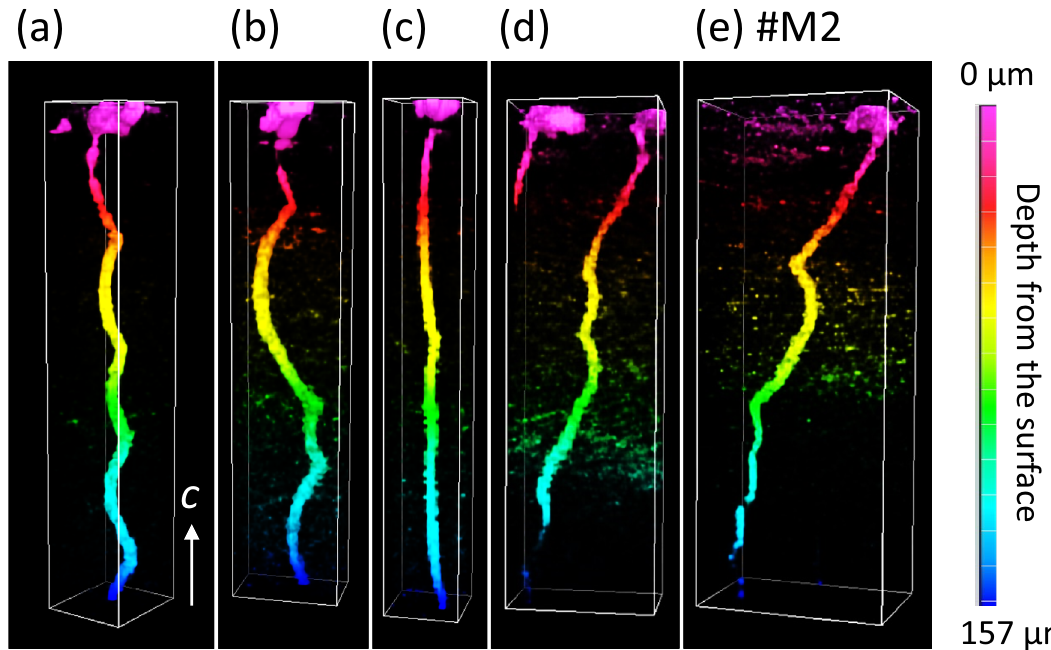
Figure 8. ( a – e ) Three-dimensional images of TDs under the M-pits. The TD in ( e ) is that under the #M2 pit. The gradient color of the TDs represents the depth from the